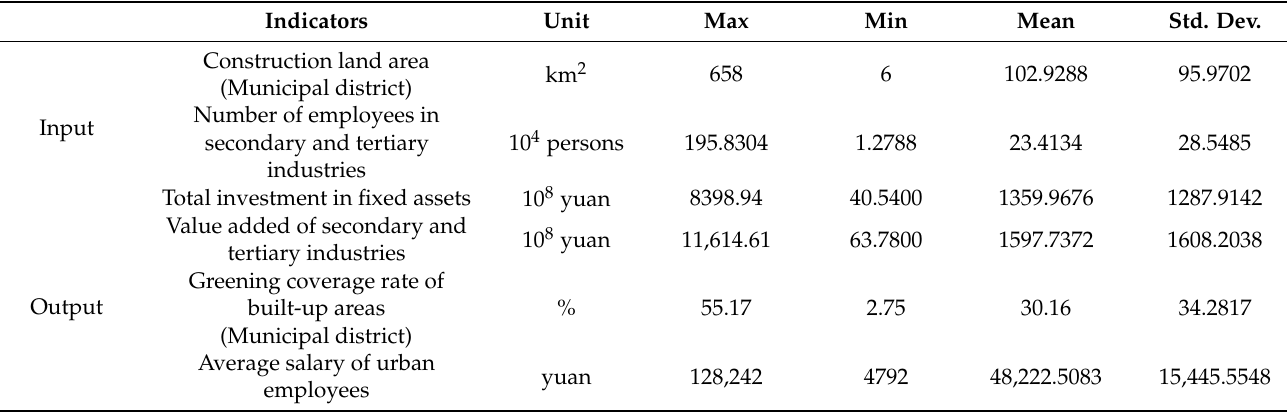
Table 1. Descriptive statistics of input and output